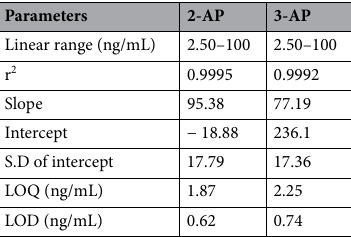
selected as the optimum buffer. While for 3-AP, 10 mM of H 2 SO 4 was selected as the optimum acidic solution because it produced the highest fluorescence intensity.